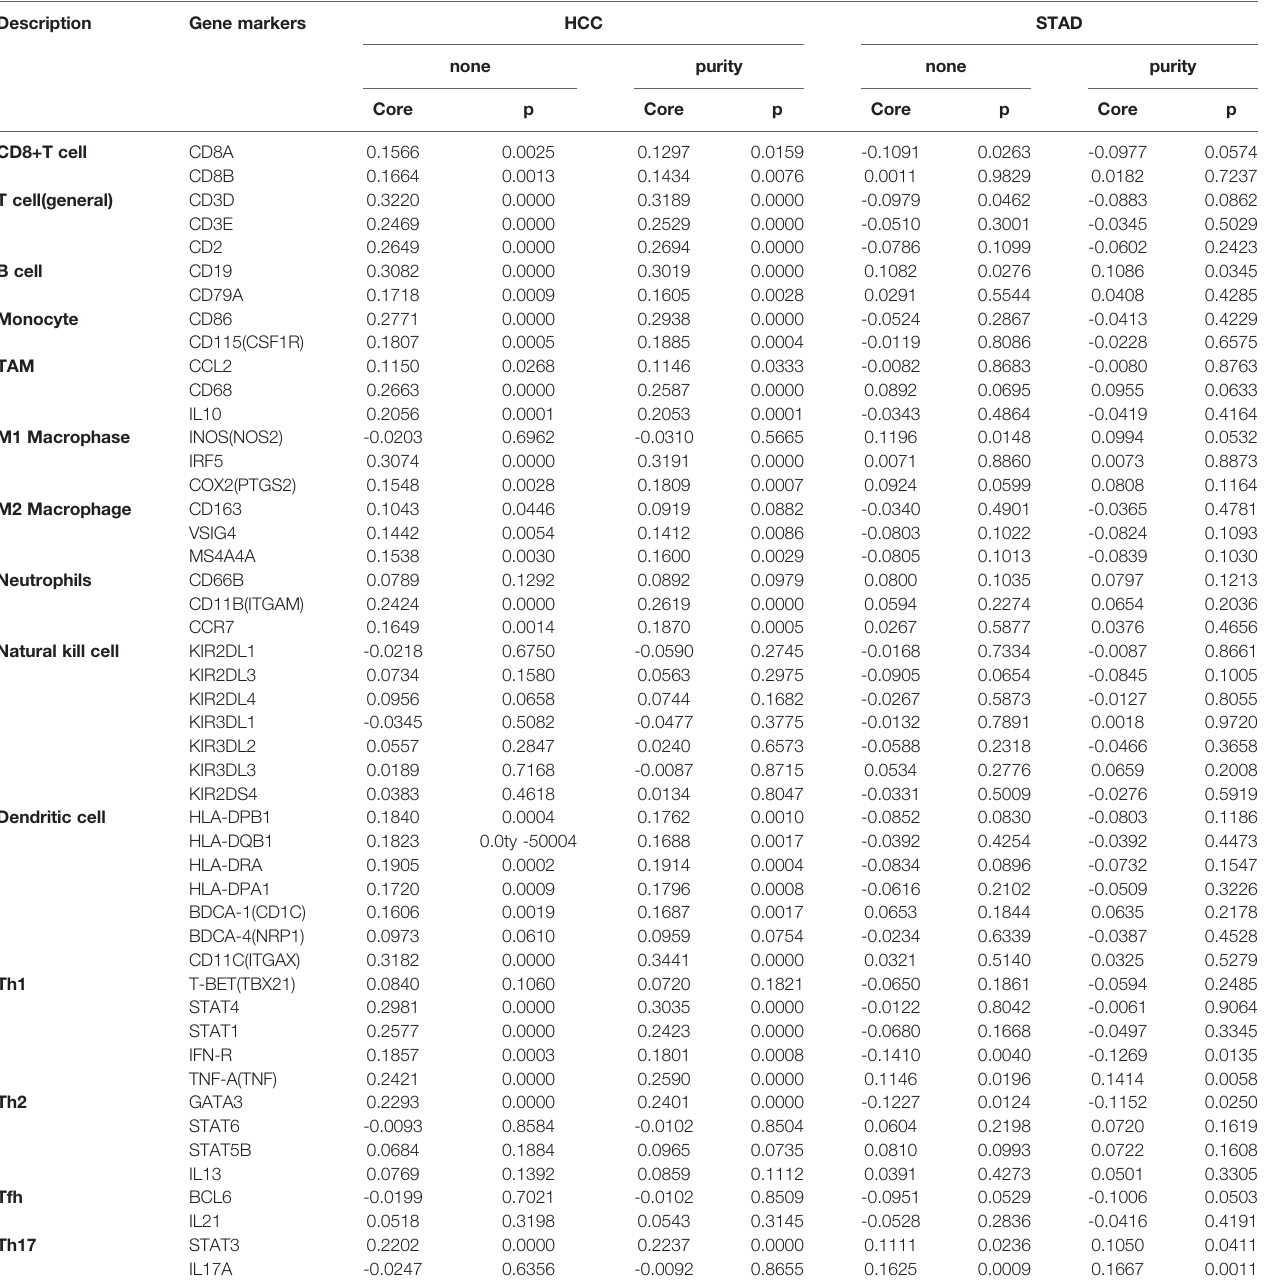
TABLE 3 | Correlation analysis between ASRGL1 and markers of immune cells in TIMER. Description Gene